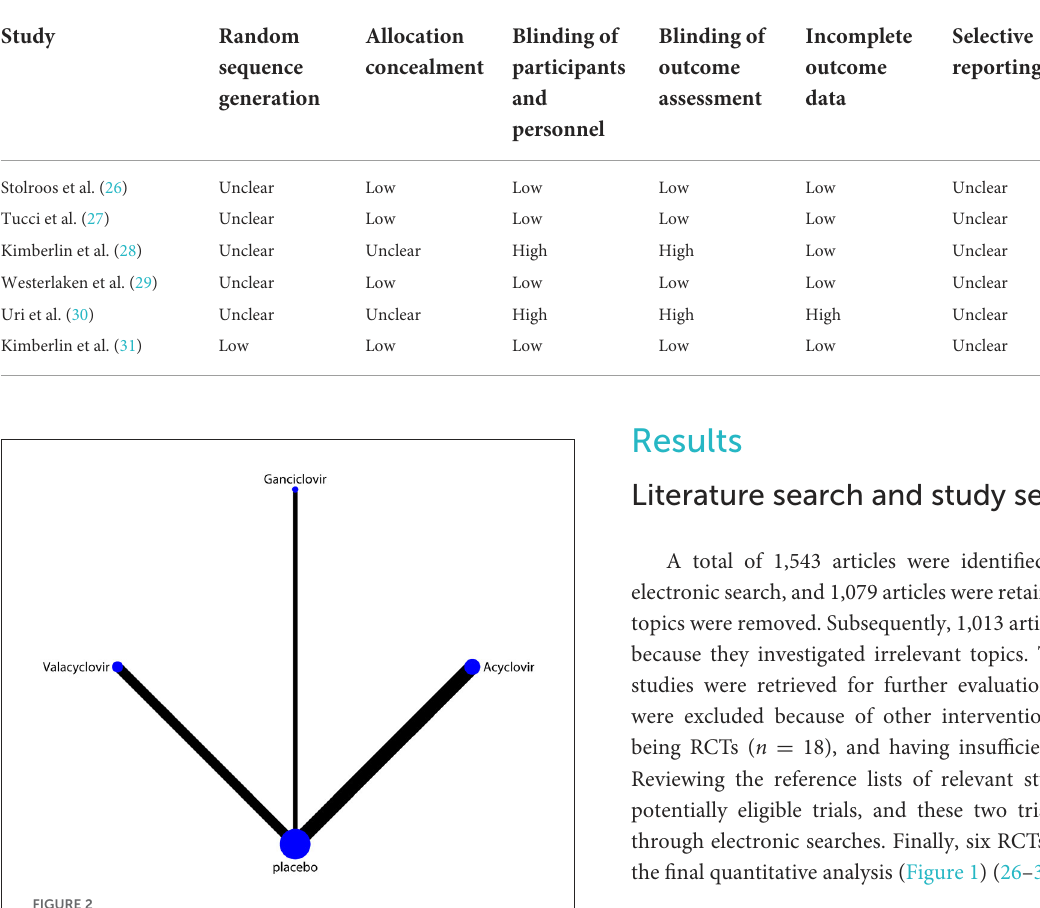
TABLE 2 Methodological quality assessment of included trials.